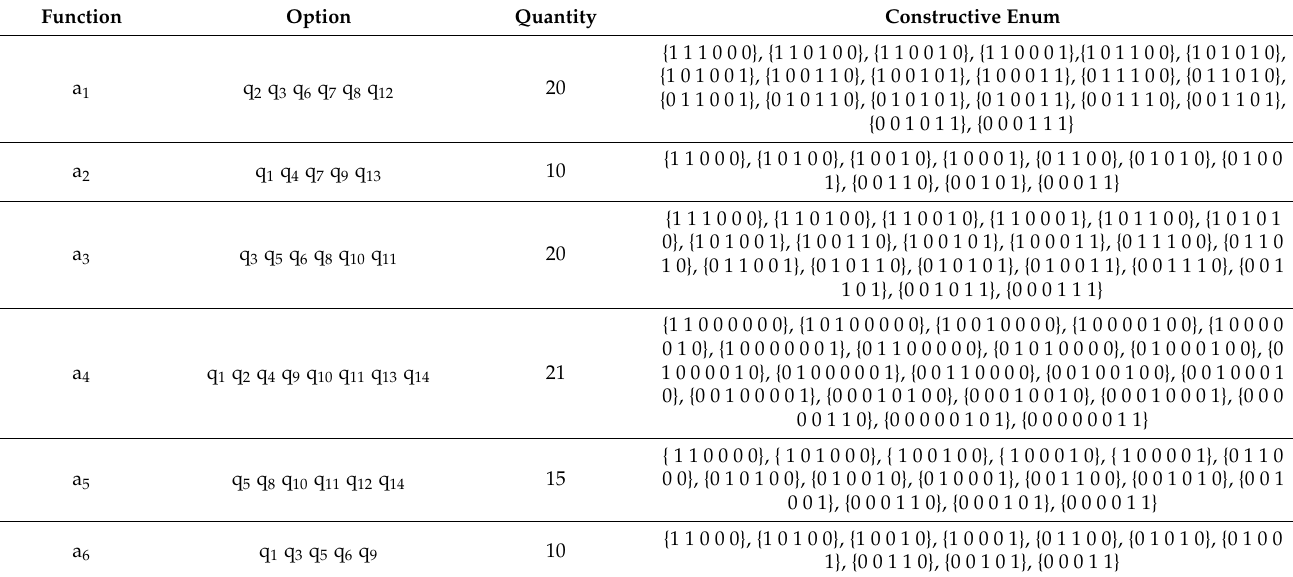
Table 5. The results of the constructive enumeration of the groups ∏ k .